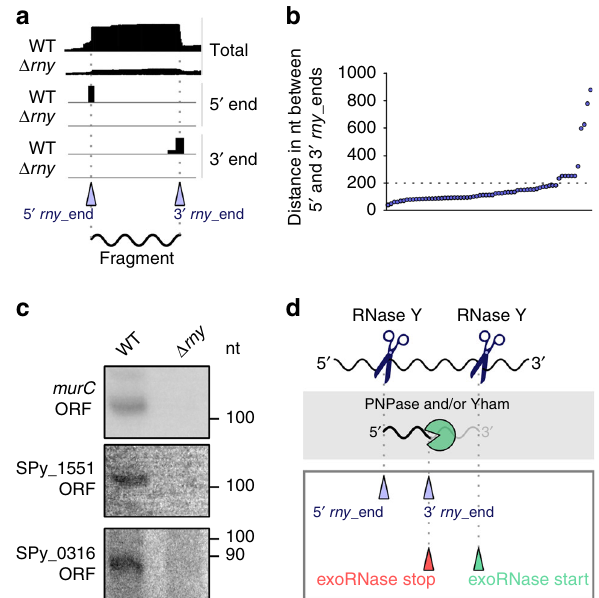
Fig. 6 Characterization of RNase Y-generated RNA fragments in the WT strain. a Representation of total, 5 ′ and 3 ′ end coverage pro fi les in the WT and Δ rny strains obtained by RNA sequencing and corresponding to RNA fragments produced by RNase Y. The 5 ′ and 3 ′ rny _ends are indicated with purple arrowheads. b The positions of the 5 ′ and 3 ′ rny _ends were compared by setting minimum and maximum distances of 40 and 1000 nt, respectively, between the ends. Each dot represents paired 5 ′ and 3 ′ rny _ends (Supplementary Data 6). c Northern blot analyses of RNA fragments in the open reading frames (ORFs) of murC , SPy_1551 and SPy_0316, generated by RNase Y and detectable only in the WT strain. The full blots, the loading controls and the RNA sequencing pro fi le for each fragment are shown in Supplementary Fig. 5c – e, and the source data are provided as a Source Data fi le. Shown are the results of one representative northern blot analysis ( n = 3). d Schematic representation of the generation of the short RNA fragments. RNase Y (blue scissors) is responsible for the production of both 5 ′ and 3 ′ fragment ends. The intermediate RNA fragment 3 ′ ends are, in 60% of the cases (Supplementary Data 6), subsequently trimmed by PNPase and/or YhaM ( ‘ pacman ’ symbol) from the start position (green arrowhead) until the stop position (red arrowhead).